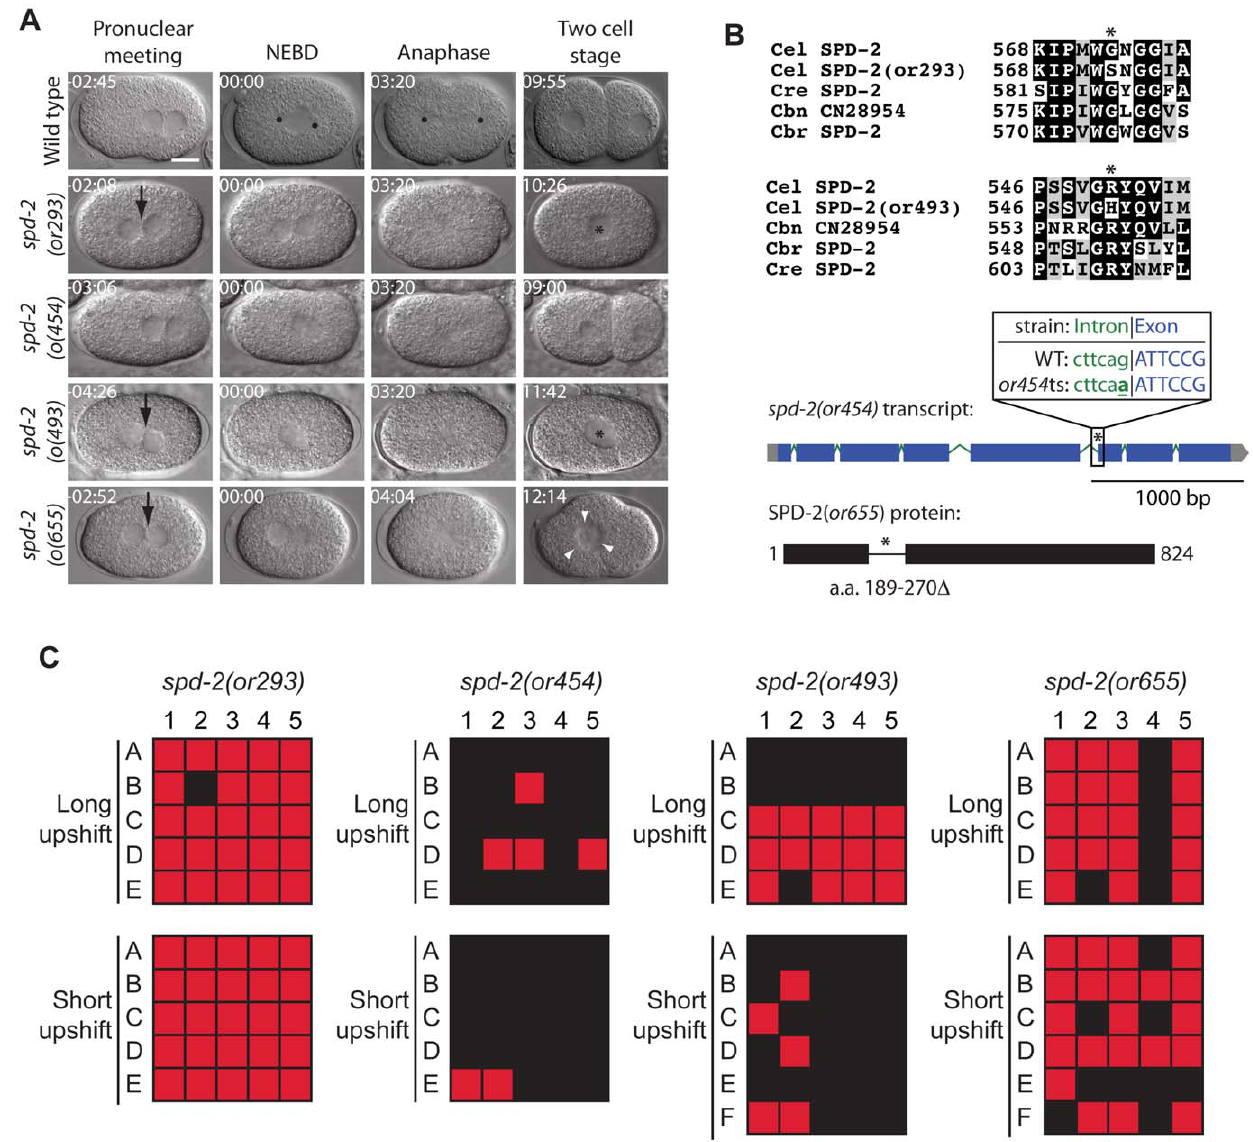
Figure 6. spd-2 mutants. A. DIC time-lapse images of wild-type, spd-2(or293 ts ) , spd-2(or454 ts ) , spd-2(or493 ts ) , and spd-2(or655 ts ) embryos. In the spd-2 mutants the pronuclei often met in the center, NCC rotation failed, a bipolar spindle failed to assemble, cytokinesis failed, and there were aberrent numbers of nuclei present at the two cell stage. The spd-2(or293 ts ), spd-2(or454 ts ), and spd-2(or493 ts ) embryos were obtained from hermaphrodites shifted to the restrictive temperature for 5–6 hours. The spd-2(or655 ts ) embryo was obtained from a hermaphrodite shifted to the restrictive temperature for , 1 min prior to imaging. Black arrows indicate instances when pronuclei meet in the center of the embryo, asterisks represent one nucleus present in a two cell stage equivalent embryo, and white arrowheads indicate multiple nuclei. Times in min:sec are given relative to nuclear envelope breakdown (NEBD). Scale bar, 10 m m. B. Sequence alterations in the mutants. Asterisks indicates the changed residues (or nucleotide for spd-2(or454 ts ) . Homologous proteins are aligned below the C. elegans protein. C. Defect maps for the spd-2 mutants. Individual embryos observed during time-lapse recordings: embryos are listed on the left and phenotypes are listed on the top: 1; nuclear centrosomal complex centration, 2; nuclear centrosomal complex rotation, 3; bipolar spindle, 4; successful cytokinesis, 5; one nucleus per cell at two cell stage. In the long upshifts, hermaphrodites were transferred to the restrictive temperature for 5–8 hours. In the short upshifts, embryos were harvested from hermaphrodites grown at 15 u C and immediately mounted on agar pads for imaging, which took , 1